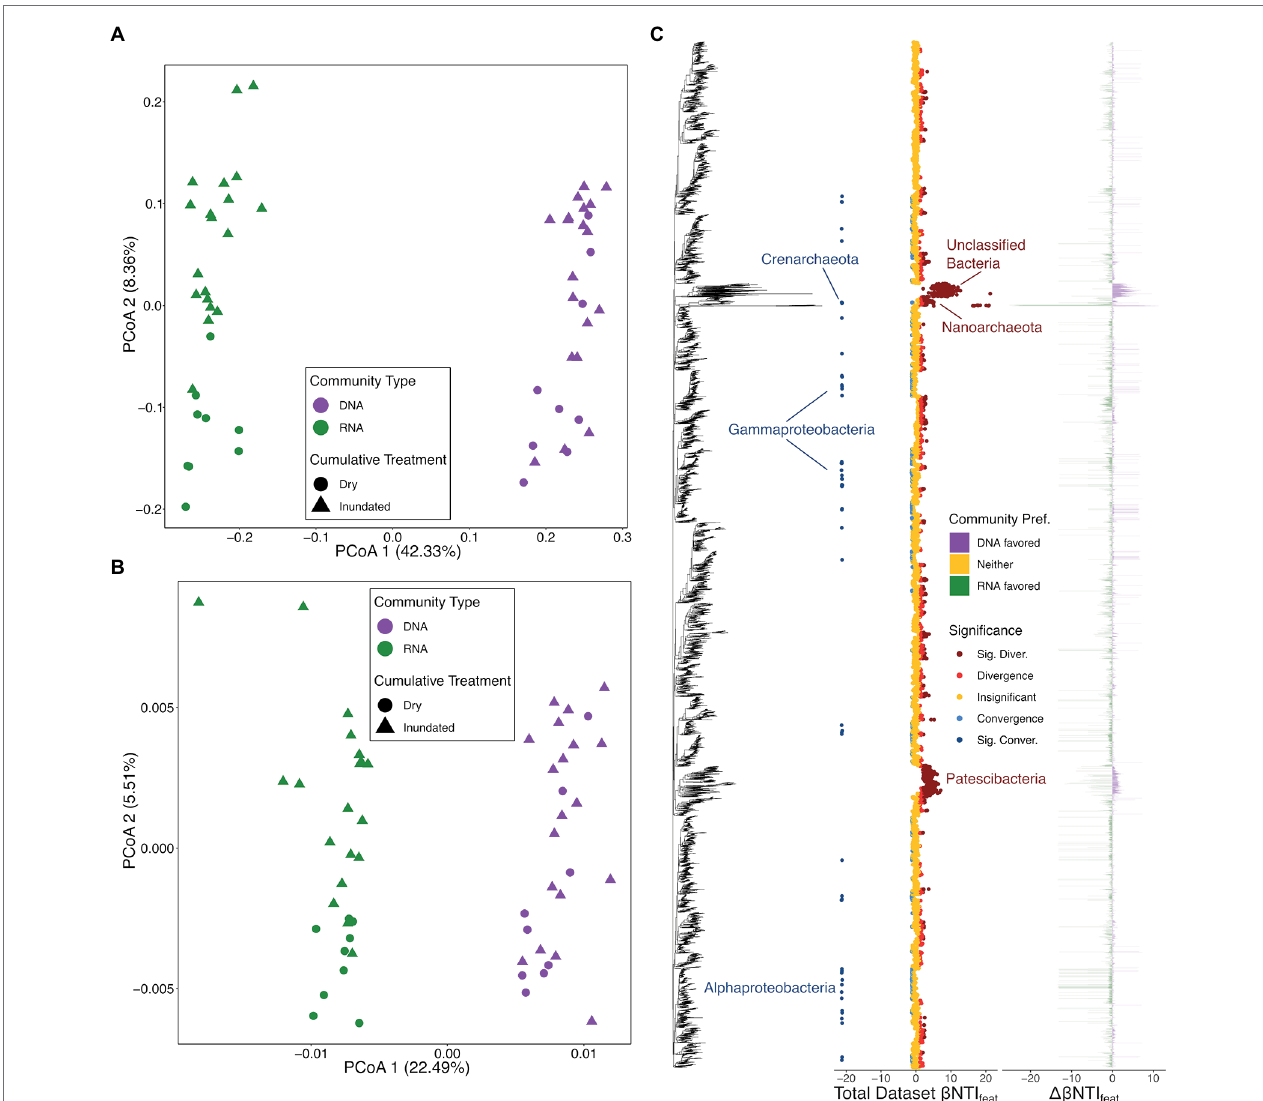
FIGURE 2 | Microbial ordinations and overview of microbial feature-level β -nearest taxon index ( β NTI feat ) results. (A) Bray–Curtis dissimilarity-based principal coordinate analysis (PCoA) with colors representing community type, the total community defined by 16S rRNA gene amplicon results (DNA) and transcribed 16S rRNA gene amplicon results (RNA), and shapes distinguishing treatment type. (B) β -mean nearest taxon distance ( β MNTD)-based PCoA with a legend matching panel (B) . (C) β NTI feat results consisting of three panels: the 16S rRNA gene amplicon tree, β NTI feat values for the whole dataset with colors indicating contribution to ecological assembly (Direction), and the difference in β NTI feat values across the total microbial community and putatively active community (Community Pref.). Under the Direction legend, “Insignificant” represent | β NTI feat | < 1, “Convergence” or “Divergence” indicate 1 < | β NTI feat | < 2, and “Sig. Conver.” or “Sig. Diver.” represent | β NTI feat | > 2. Under the Community Pref. legend, “DNA favored” indicates that the given microbial group had a higher absolute β NTI feat value in the total community, “RNA favored” indicates that the given microbial group had a higher absolute β NTI feat value in the putative active community, and “Neither” indicates no difference between communities. Microbial groups discussed throughout the manuscript are called out where